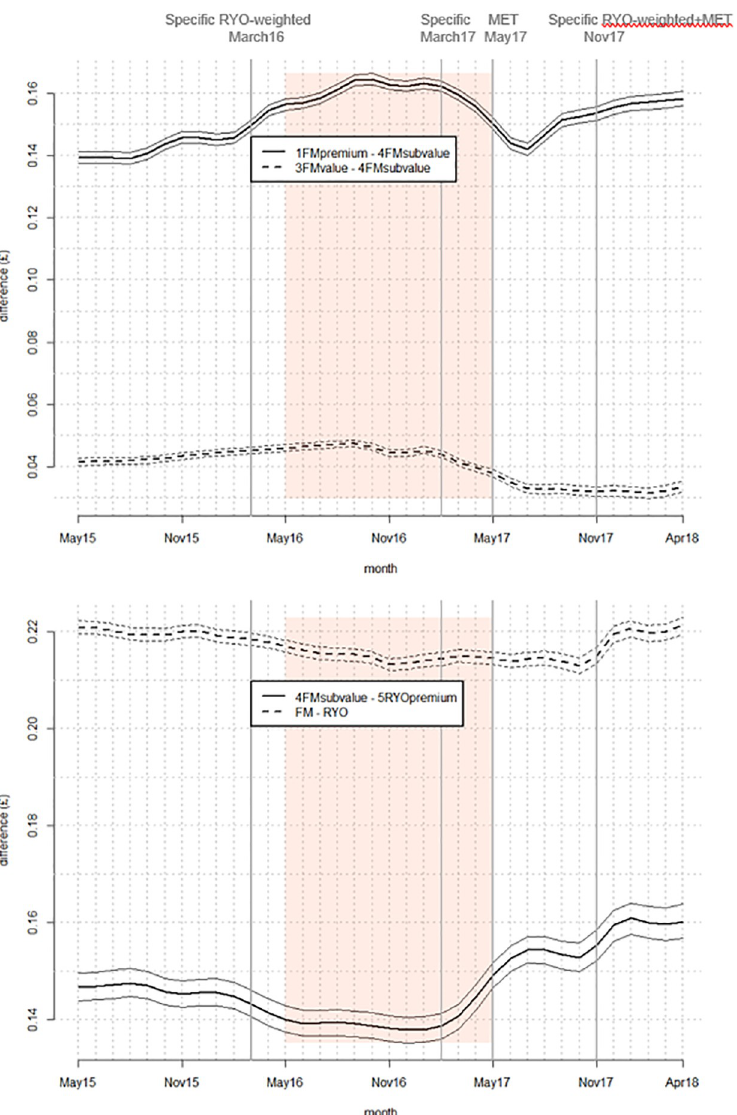
Fig 3. Gaps in weighted average real price per stick between (a) selected FM market segments and (b) FM subvalue and RYO premium and FM and RYO overall (vertical lines denote tax changes and the shaded area is the standardised packaging implementation